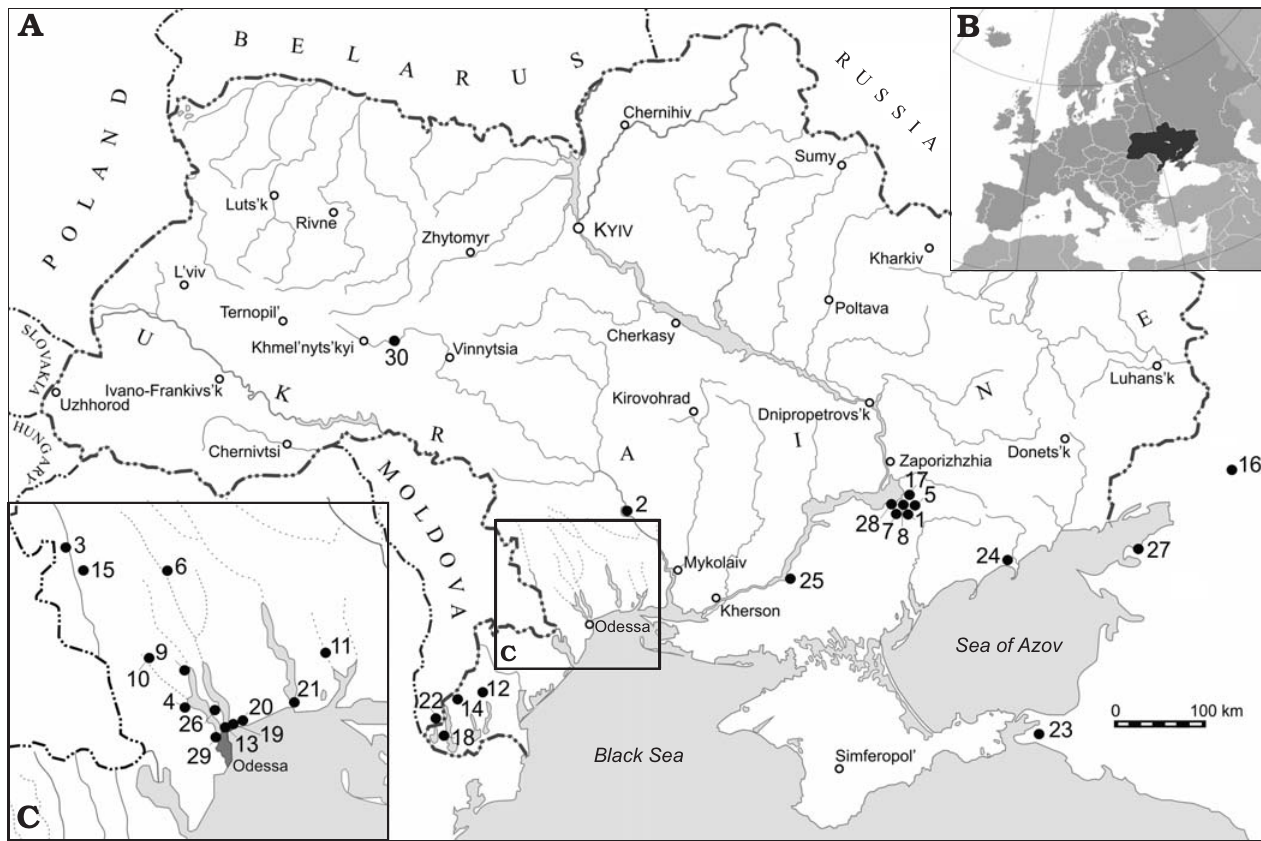
Fig. 1. Map showing location of Ukraine in Europe ( B ). Localities with fossil pike remains in southeastern Europe in Ukraine ( A ), detailed view of area near Odessa ( C ). 1, Popovo; 2, Mykhailivka; 3, Frunzovka; 4, Palievo; 5, Lobkovo; 6, Cherevichne; 7, Vasylivka; 8, Verkhnya Krynitsya; 9, Egorovka; 10, Novoukrainka; 11, Andreevka; 12, Orekhovka; 13, Pontian Lectostratotype; 14, Vinogradovka; 15, Novopetrovka; 16, Obukhovka; 17, Kamenskoe; 18, Kotlovina; 19, Zhevakhova Gora; 20, Kryzhanovka; 21, Tiligul; 22, Nova Etuliya; 23, Sinyaya Balka; 24, Nogaisk; 25, Kairy; 26, Protopopovka; 27, Semibalka; 28, Lysa Gora; 29, Bol’shevik; 30,